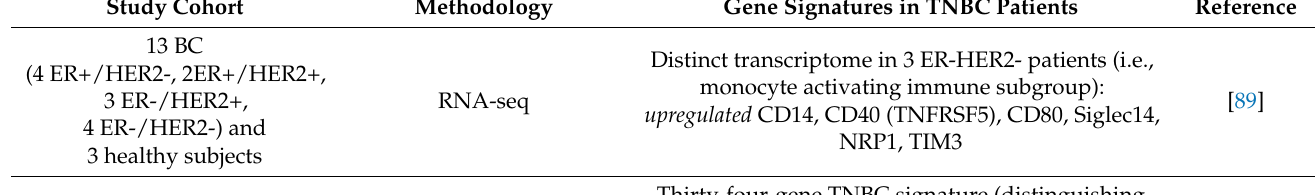
Table 2. Peripheral blood transcriptome studies describing gene expression signatures in TNBC